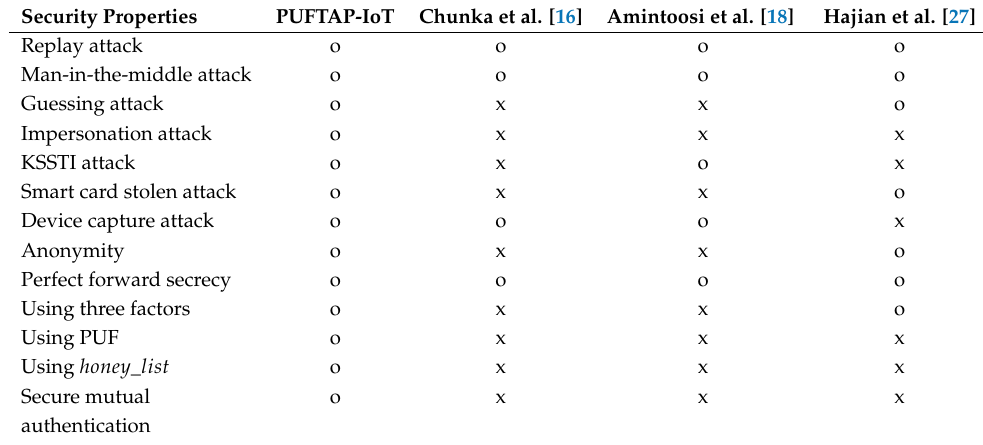
Table 3. Security properties comparison.